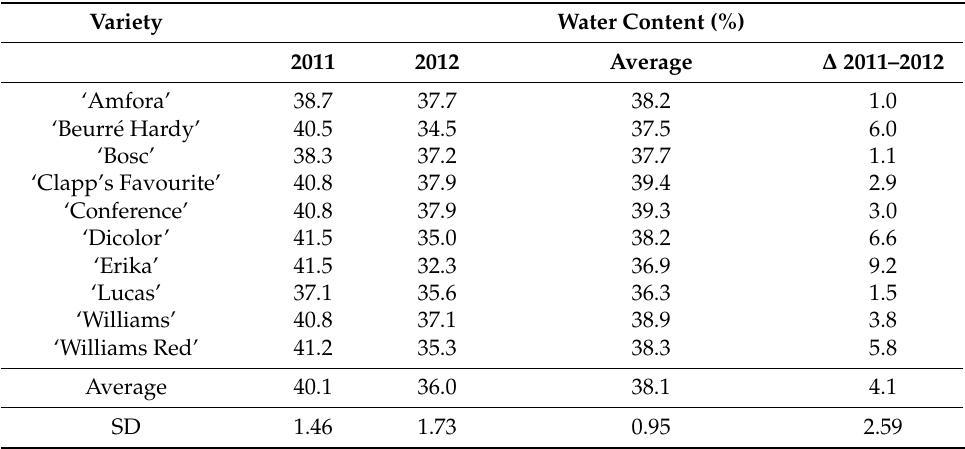
Table 1. The water content of dormant pear buds after freeze-drying before a two-step cryopreserva- tion cryoprotocol. The water content of varieties in 2011, 2012, the average water content and the difference between 2011 and 2012 is